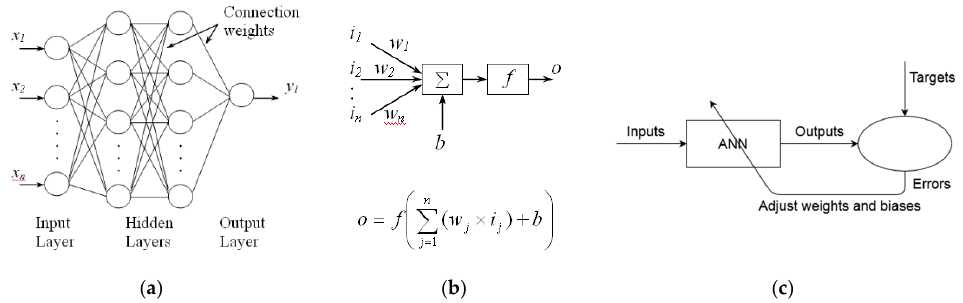
Figure 4. ( a ) Typical ANN architecture, ( b ) Computational Model of a Single Neuron, ( c ) ANN training process.